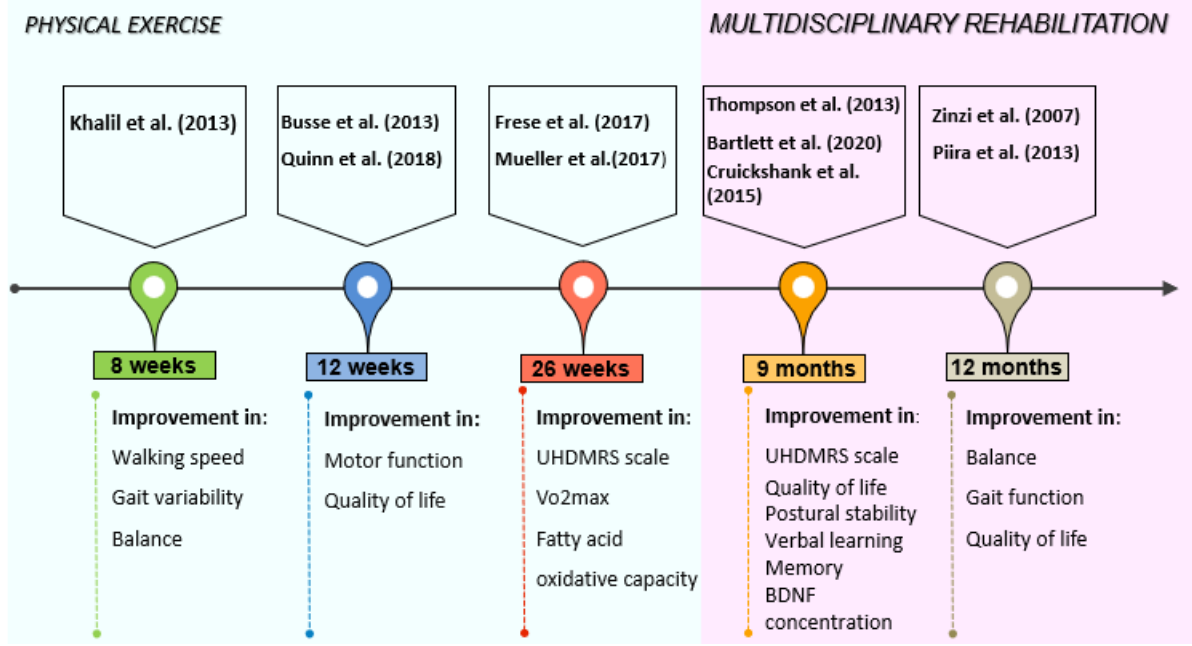
Figure 2. Intriguing timeline of physical exercise and multidisciplinary rehabilitation interventions with their relative outcomes.